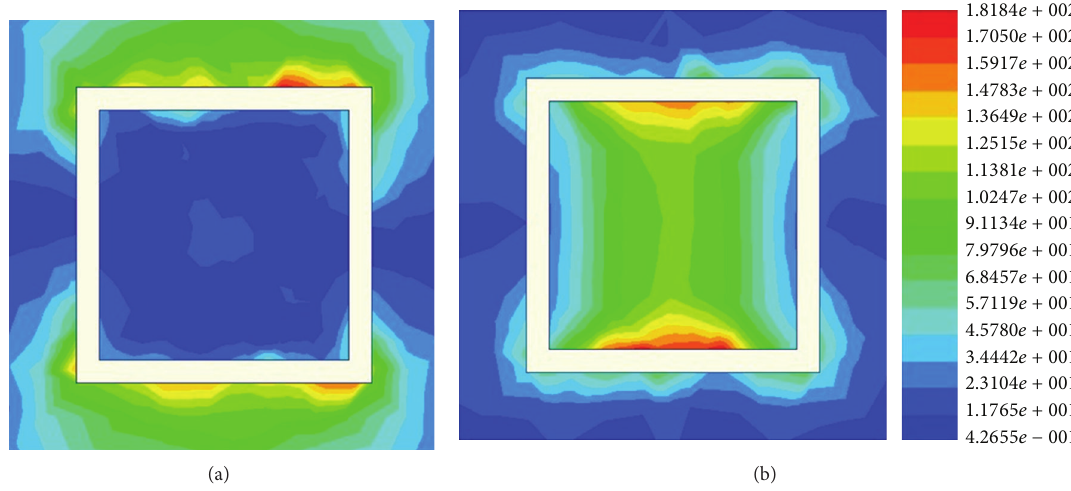
Figure 3: Surface current distribution of the dual-band AMC structure at (a) 2.45 GHz, (b) 5.8